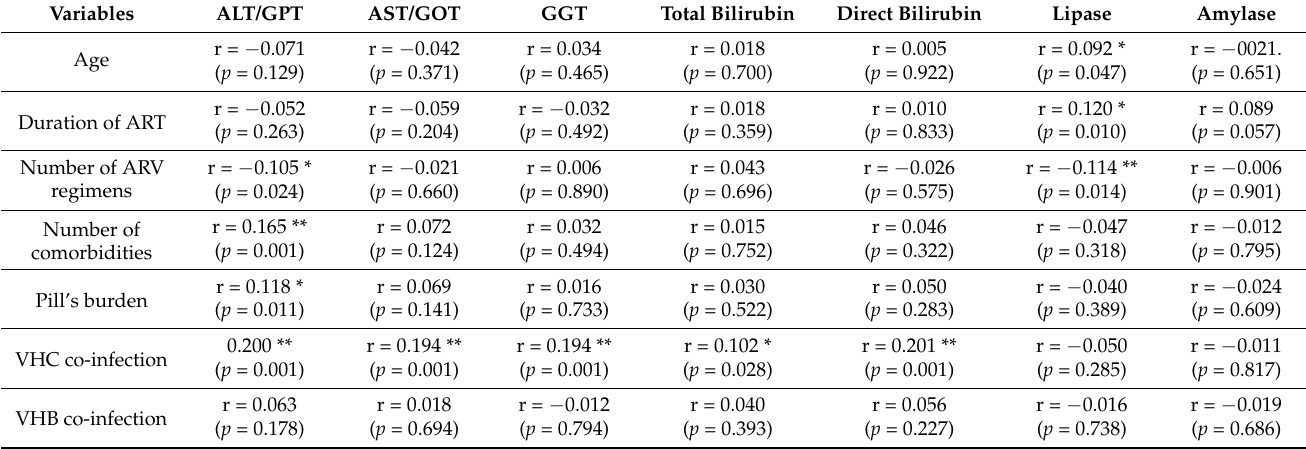
Table 10. Pearson correlation on the risk of liver function in HIV positive patients (N = 462).